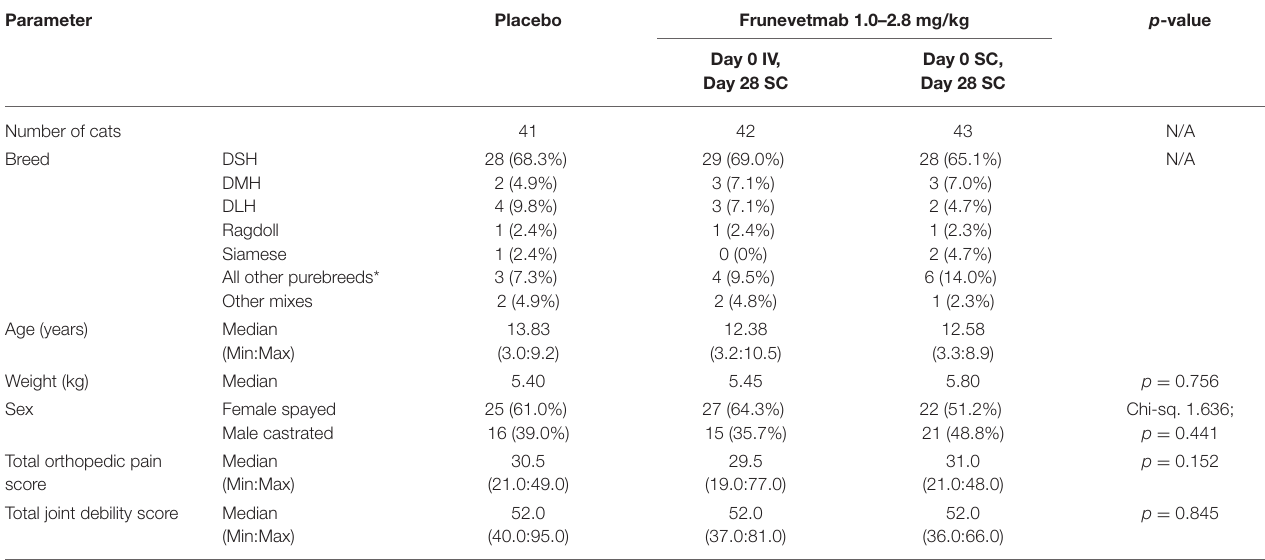
TABLE 1 | Demographic characteristics of cats in each treatment group. Parameter